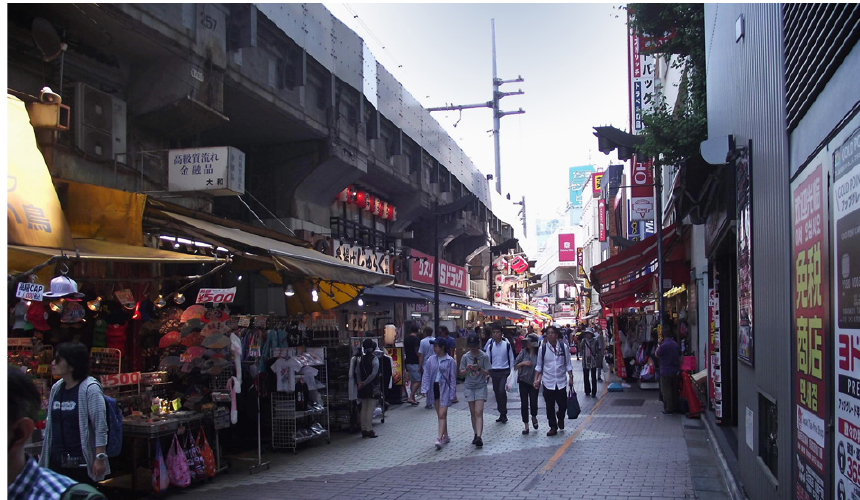
Figure 1. Ameya-Yokochō Street